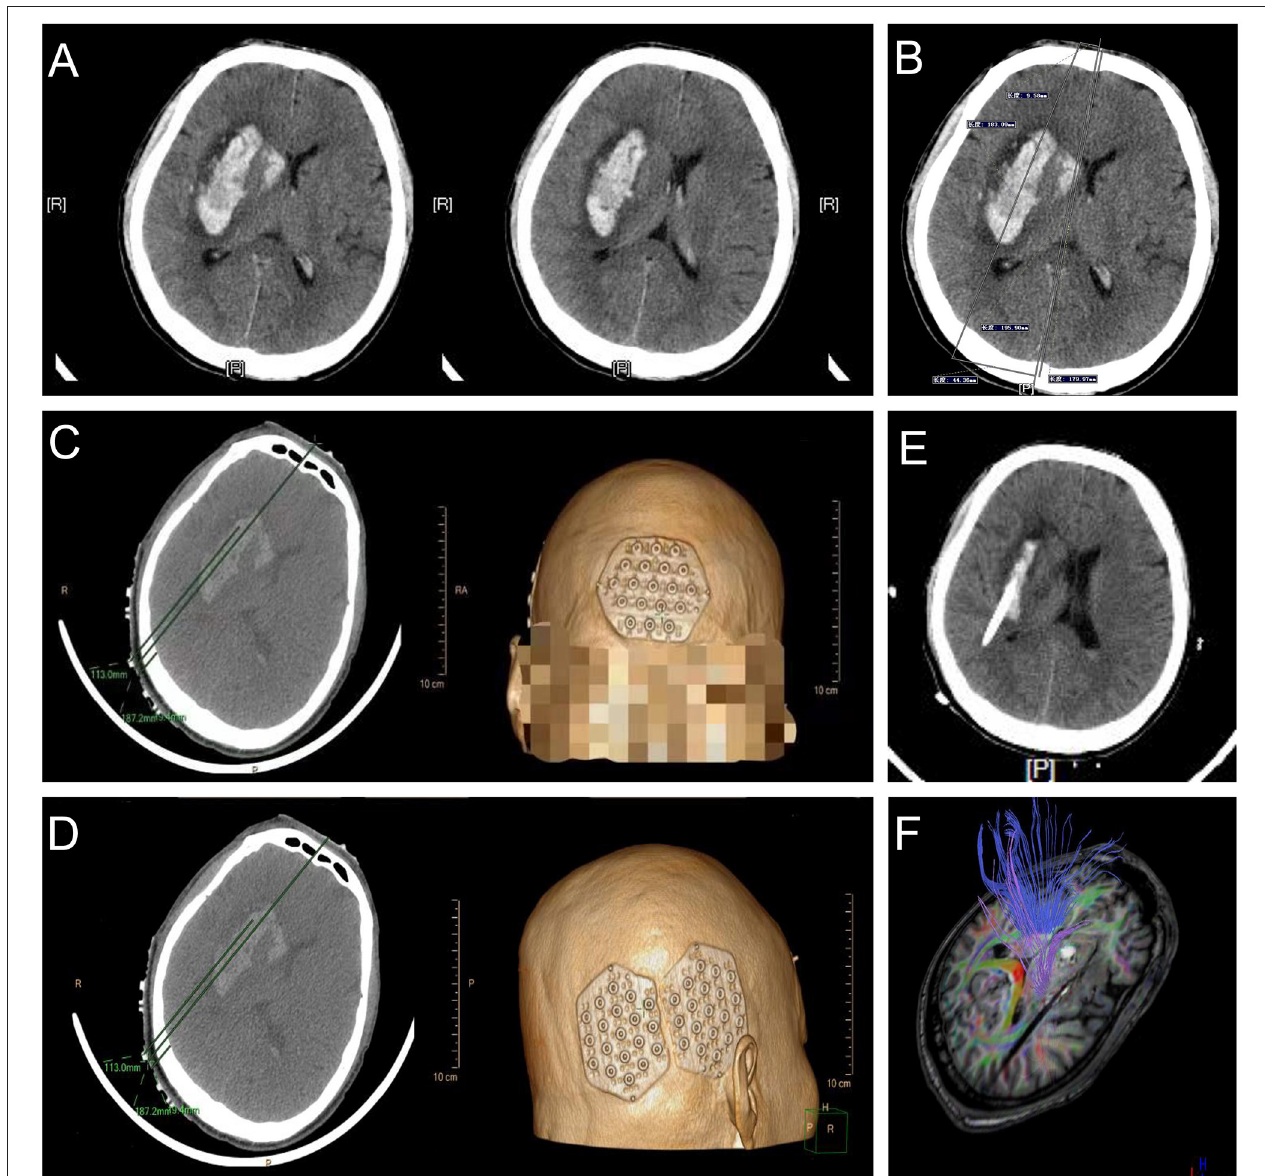
FIGURE 10 | Basal ganglia hemorrhage appears in (A) , with a vertical distance of 9.58mm (reference point) from the centerline and a parallel distance of 179.97mm (puncture point) along the centerline in (B) used to locate the location sticker in (C,D) . (E,F) represent good clinical